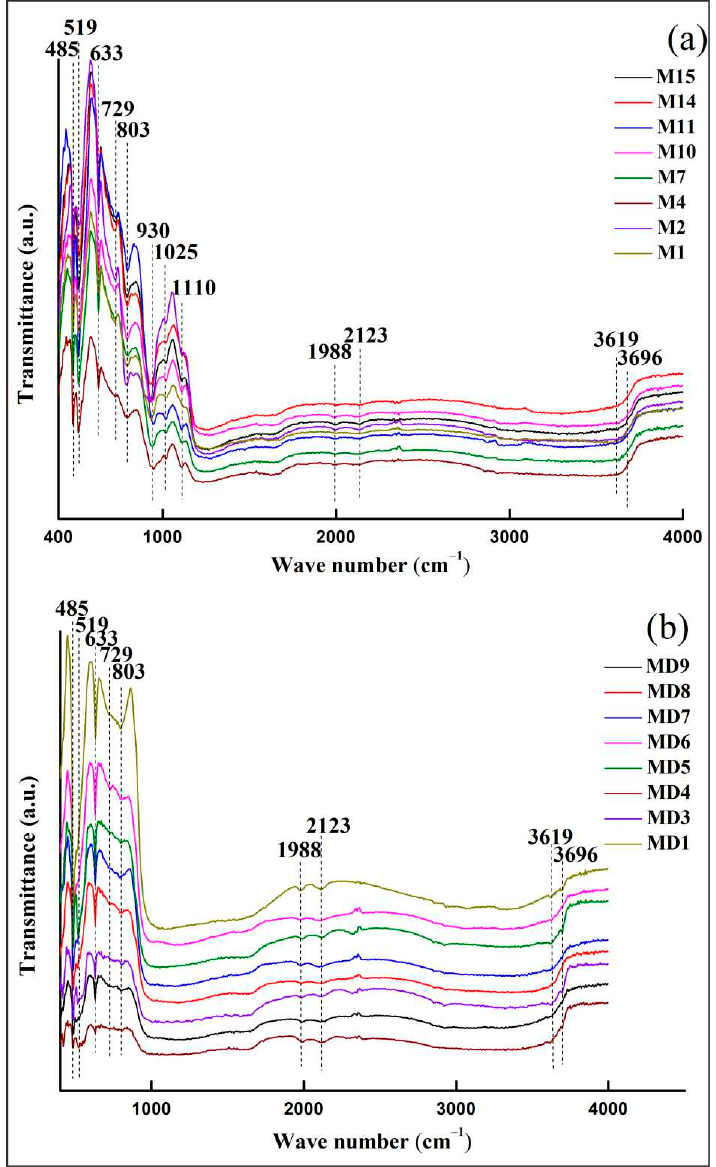
Figure 6. Representative FTIR spectra of sapphire. ( a ) FTIR spectra of rough samples. ( b ) FTIR spectra of curved samples.